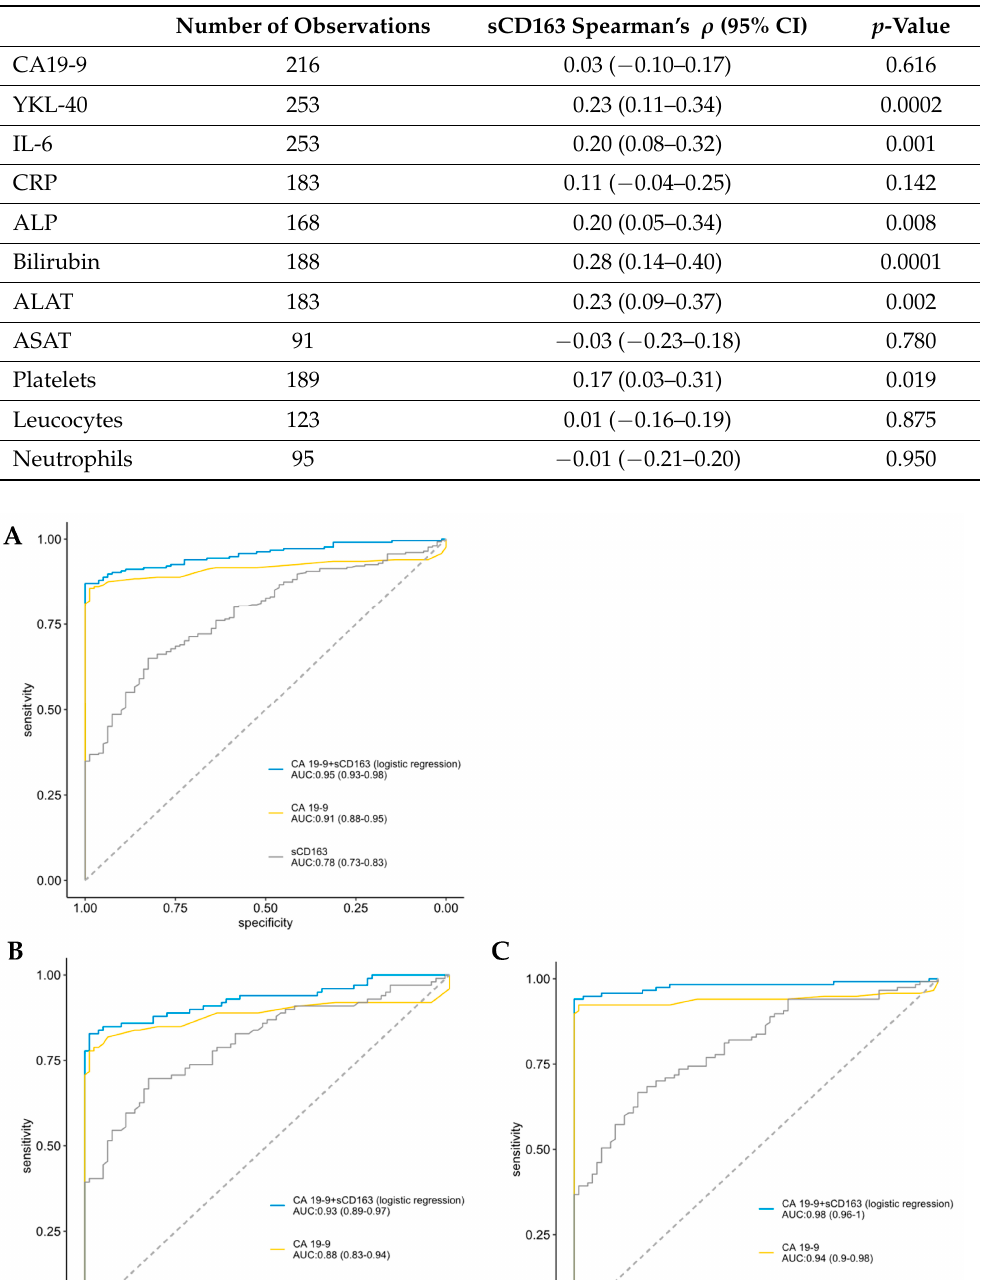
Table 2. Correlations between sCD163 and CA19-9, YKL-40, IL-6, CRP, ALP, bilirubin, ALAT, platelets, leucocytes, and neutrophils.